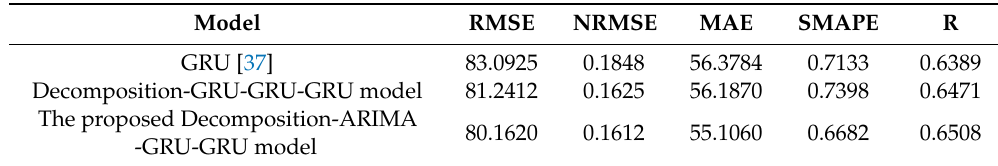
Table 1. Comparison of the 24-step (24 h) prediction results.